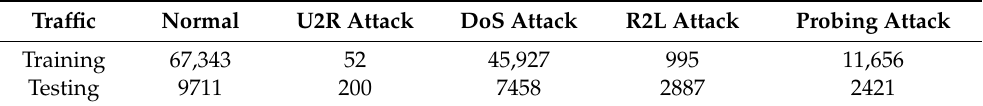
Table 2. Summary of NSL-KDD